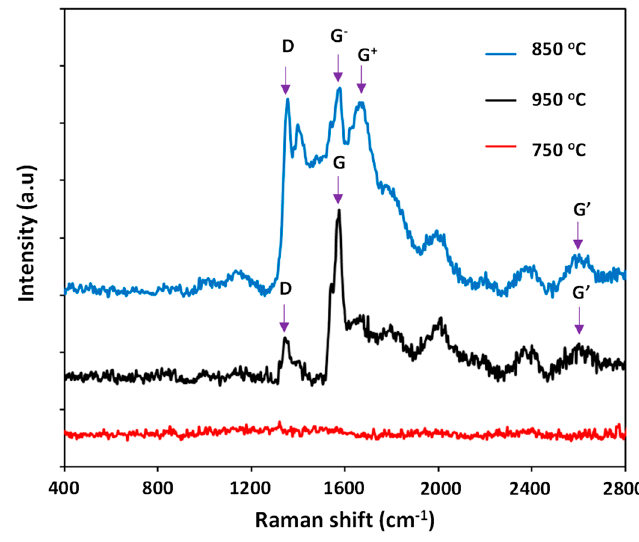
Figure 3. Raman spectra of the formed CNTs at different pretreatment temperatures.